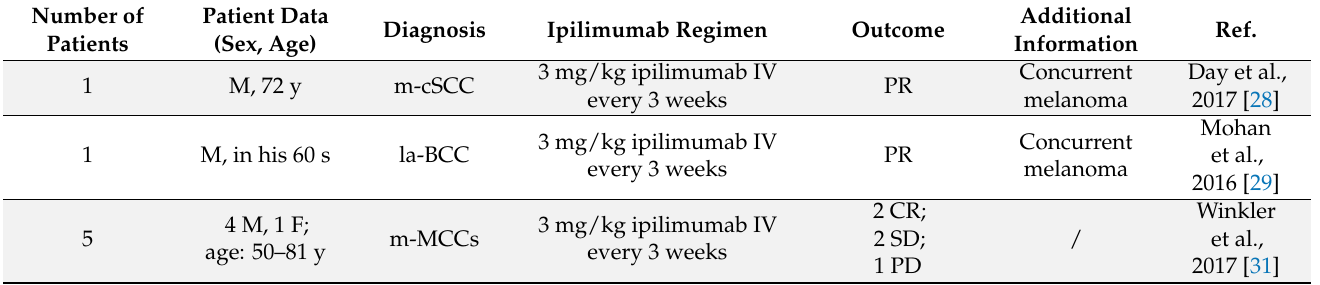
Table 1. Reported cases of locally advanced and metastatic non-melanoma skin cancers treated with